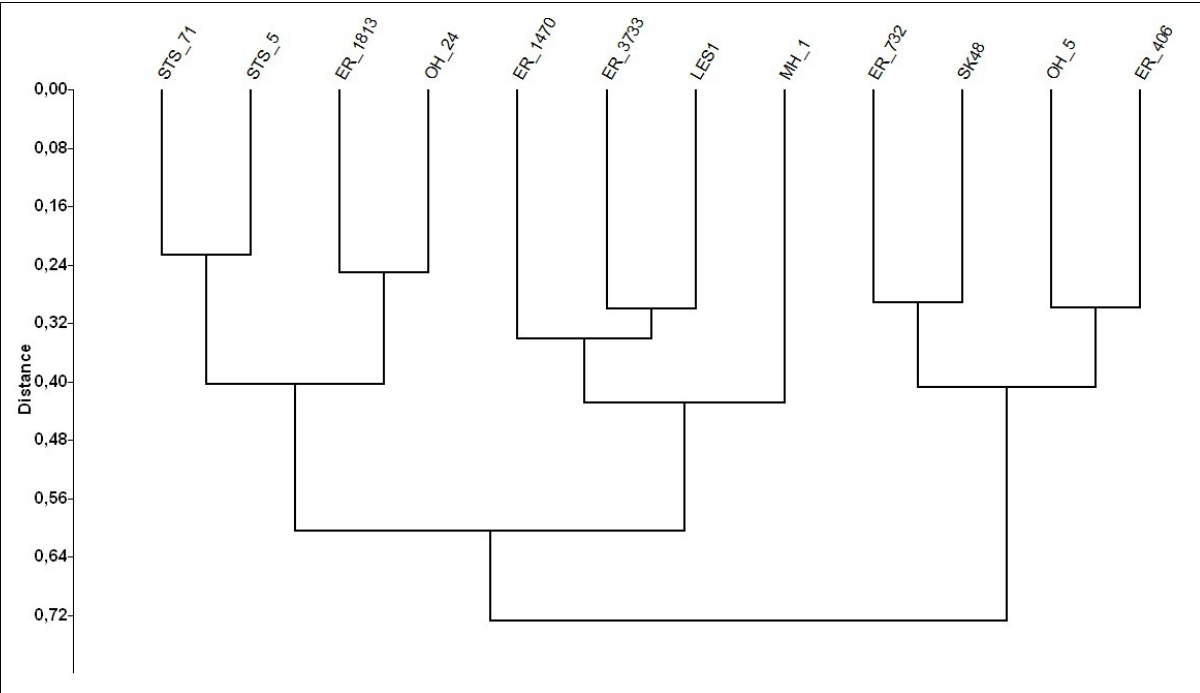
Figure 3: Phenetic tree obtained from UPGMA cluster analysis of log sem statistics based on pairwise linear regression analyses of cranial measurements of Plio-Pleistocene hominins, using measurements published primarily by Wood 14 . Three general groups are distinguished, whereby specimens attributed to Paranthropus are distinct from others attributed to Australopithecus and Homo . Sts 5 and Sts 71 are specimens of Australopithecus from Sterkfontein, South Africa. KNM-ER 1813 (Turkana Basin, Kenya) and OH 24 (Olduvai Gorge, Tanzania) have been attributed to H. habilis but group with A. africanus . KNM-ER 1470 ( H. rudolfensis ) and KNM-ER 3733 ( H. ergaster ) are both from the Turkana Basin. South African specimens LES 1 ( H. naledi ) and MH 1 ( A. sediba ) are from Rising Star and Malapa Caves, respectively. KNM-ER 406 and KNM-ER 732 are specimens of Paranthropus boisei from the Turkana Basin. The latter species is also represented by OH 5 from Olduvai Gorge. SK 48 represents P. robustus from Swartkrans, South